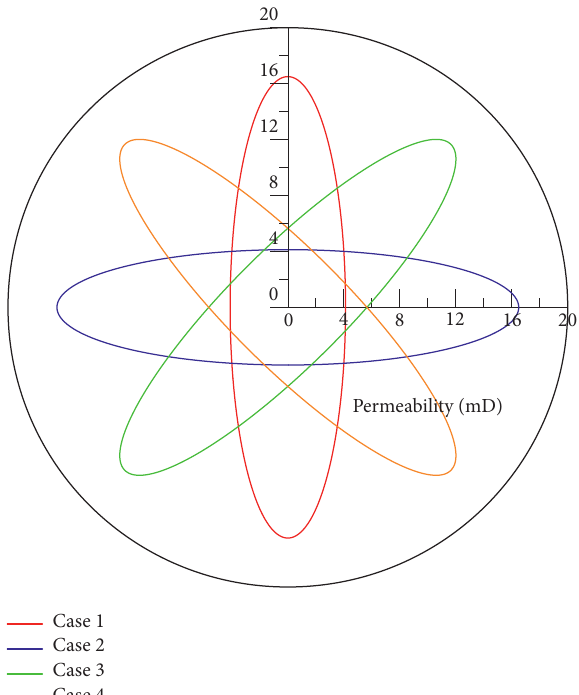
Figure 25: Initial permeability tensors for four cases.